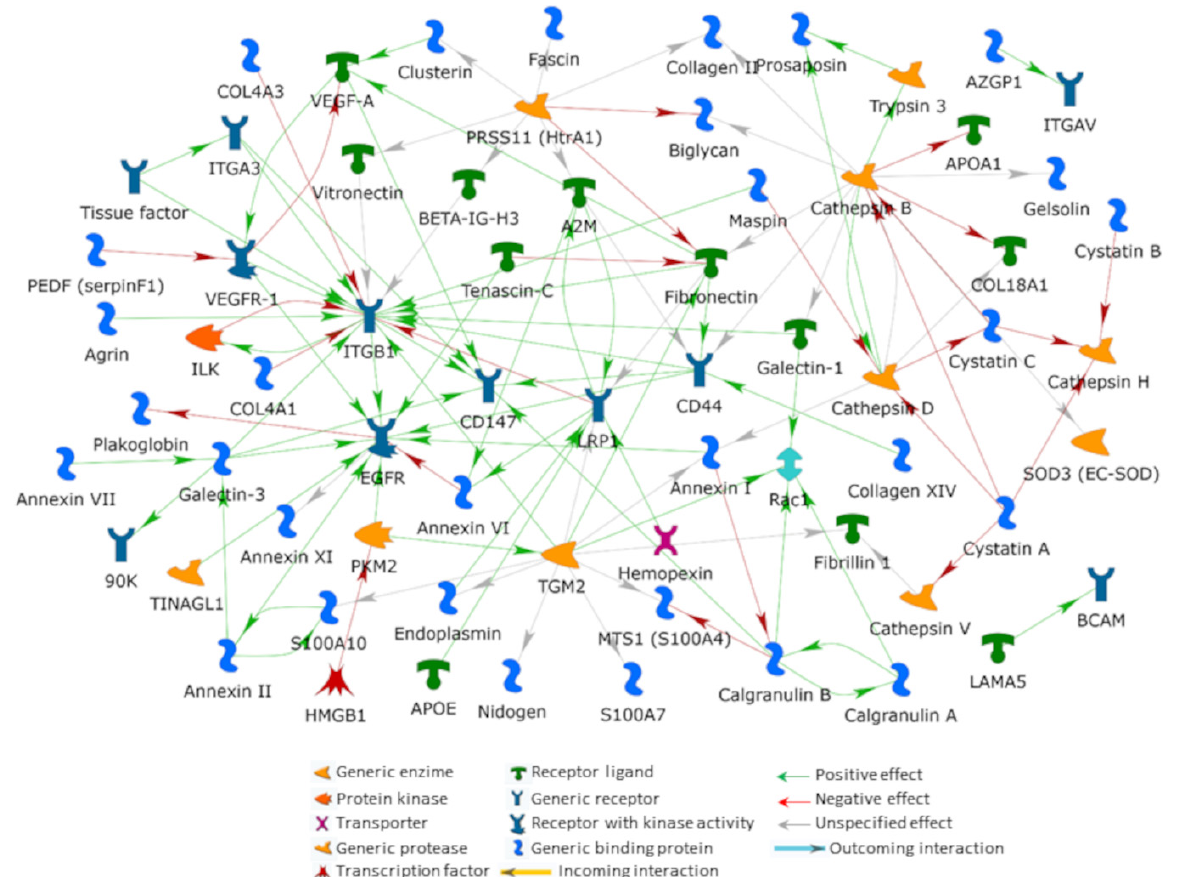
Figure 3. Direct interaction net . DIN of 61 proteins present in the ECM of the iERMs and selected from those reported by Christakopoulos et al. [13]. Types of proteins and effects of their interactions are coded according to the legend at the bottom of the figure.